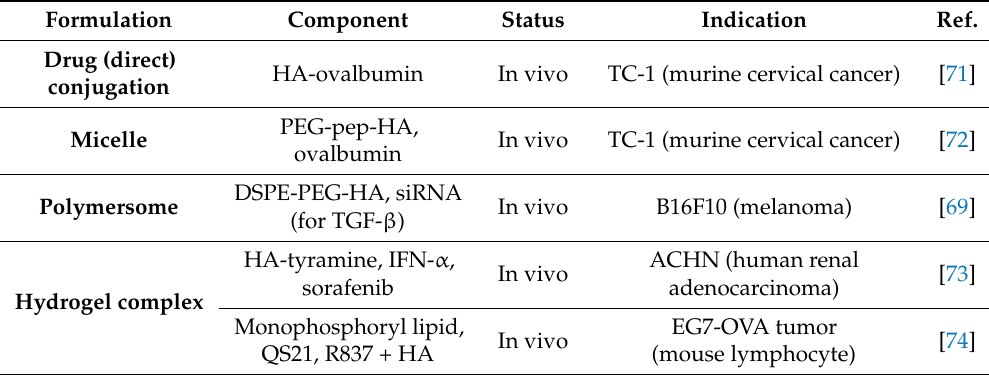
Table 3. Summary of recent principal research for immunotherapy using HA-based